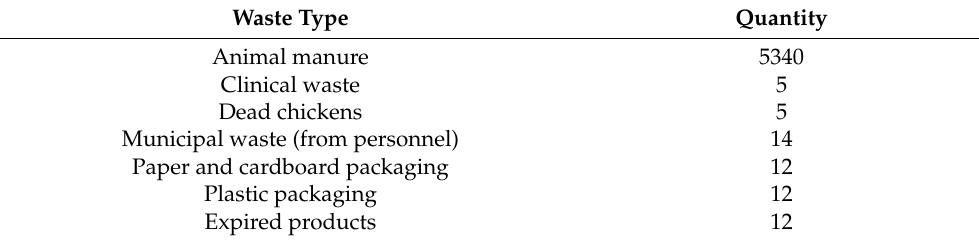
Table 2. Meat and poultry industry waste streams (in tonnes per year) 1 .